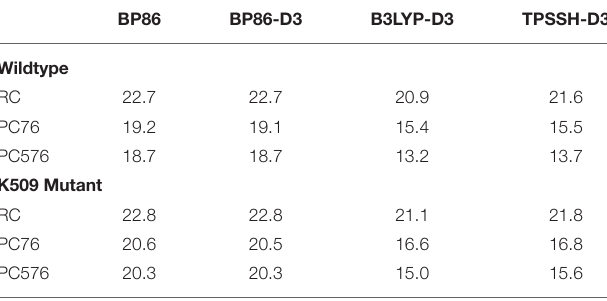
FIGURE 6 | Schematic representation of the role of arginine 509 in hydrogen binding and oxidation by [NiFe]-hydrogenases.